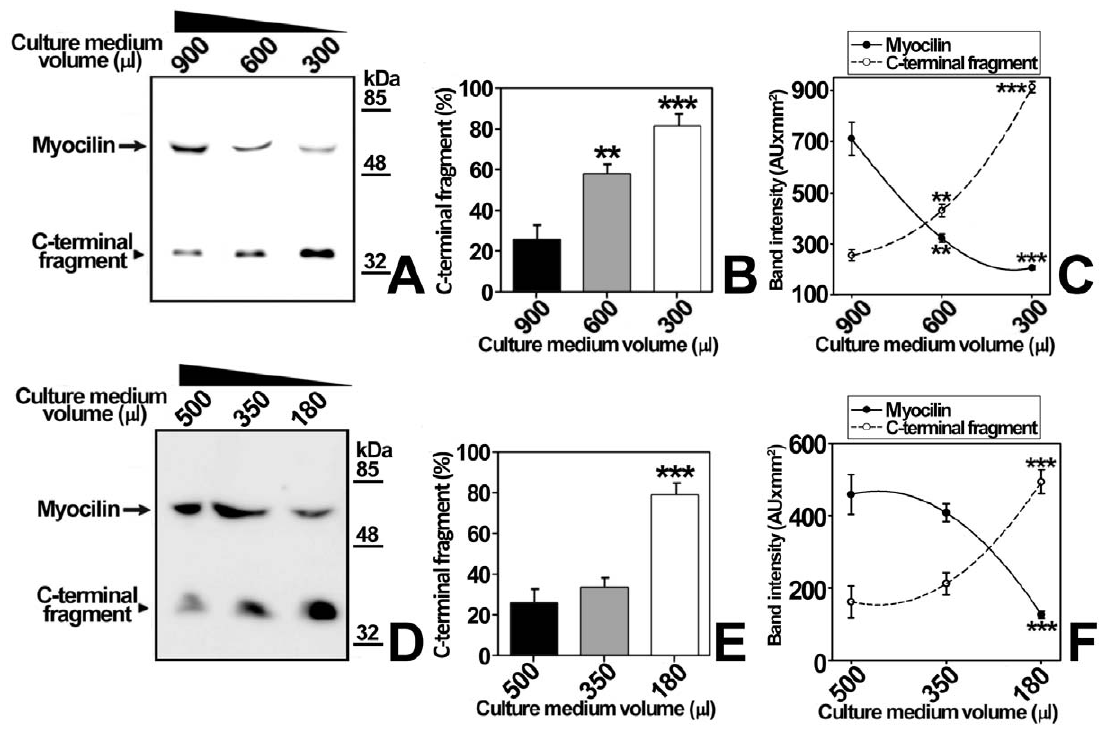
Figure 3. Influence of the culture medium volume in proteolytic myocilin processing. (A) HEK-293T cells (400000 cells/well) were transfected with a cDNA construct encoding myocilin-myc. After transfection, the indicated volumes of culture medium were added to each well and collected 48 h later. Extracellular recombinant myocilin was analyzed in normalized aliquots representing 5% of the total culture medium volume by 10% polyacrylamide SDS-PAGE and Western blot using an anti-myc monoclonal antibody. (B) Densitometric relative quantitation of the C-terminal fragment detected in A. Values represent the proportion of this myocilin fragment, expressed as indicated in Fig. 1B. (C) Densitometric quantitation of the full-length and C-terminal myocilin fragment detected in A. (D) The human ocular cell line hCM stably expressing recombinant myocilin-HA (400000 cells/well) were cultured with different volumes of culture medium as indicated in (A). (E) and (F) Recombinant myocilin secrected by hCM cells was quantitated as indicated in (B) and (C), respectively. Error bars correspond to the SD of two independent experiments carried out in triplicate. Asterisks indicate statistical significance compared to the first volume: p , 0.01 (**); p , 0.001 (***). One-way ANOVA followed by Tukey multiple-comparison test.